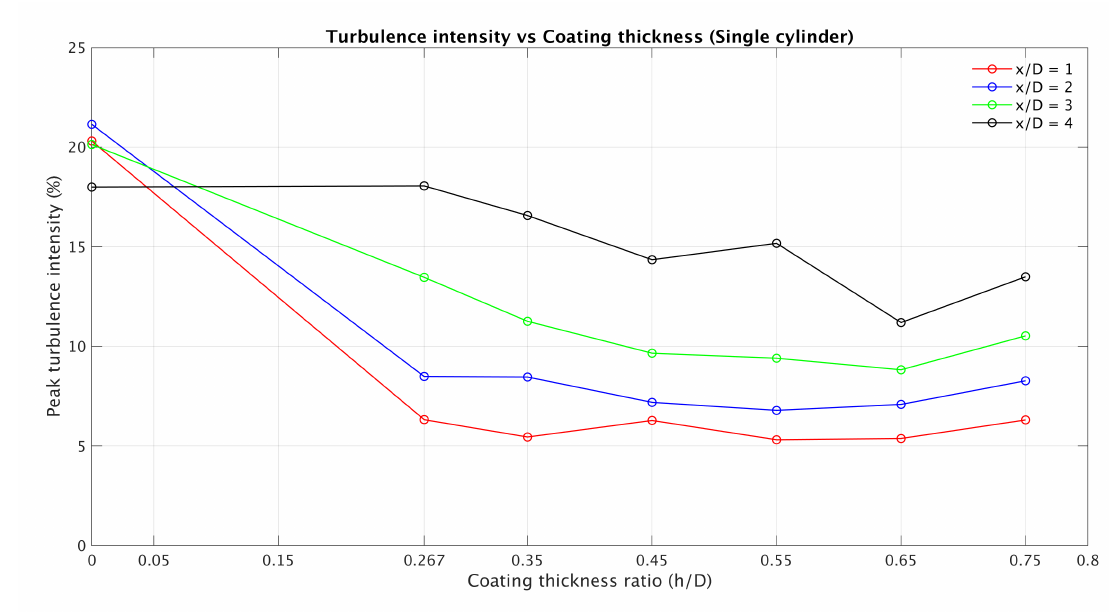
Figure 17. Turbulence intensity vs coating thickness trend for single cylinder.